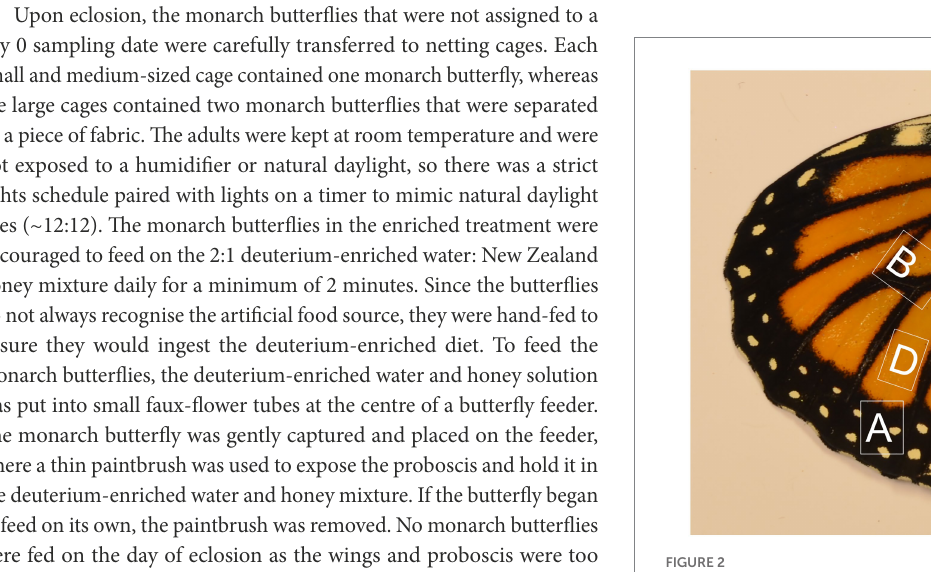
FIGURE 2 Annotated photo depicting the location of samples on the right hindwing. S is the location of the standard samples (dark orange, no vein and scaled), A is the location of black samples, B is the location of samples with vein, C is the location of light orange samples, and D is the location of samples with no scales (scales were manually removed). Results from samples from location S were used for linear regression modelling and the Tukey HSD test for the δ 2 H of wing samples analysis. Results from samples from locations S, A, B, C, and D were used for the paired t -tests for the analysis of intra-wing